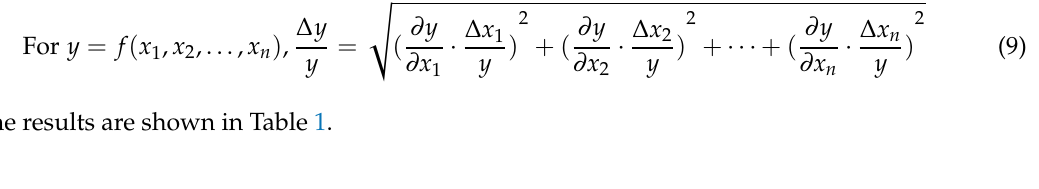
Table 1. Experimental Uncertainties.